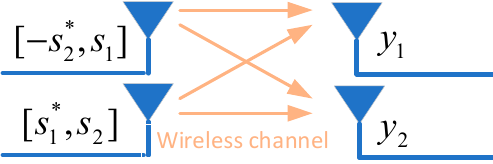
Figure 3. MIMO wireless channel model.